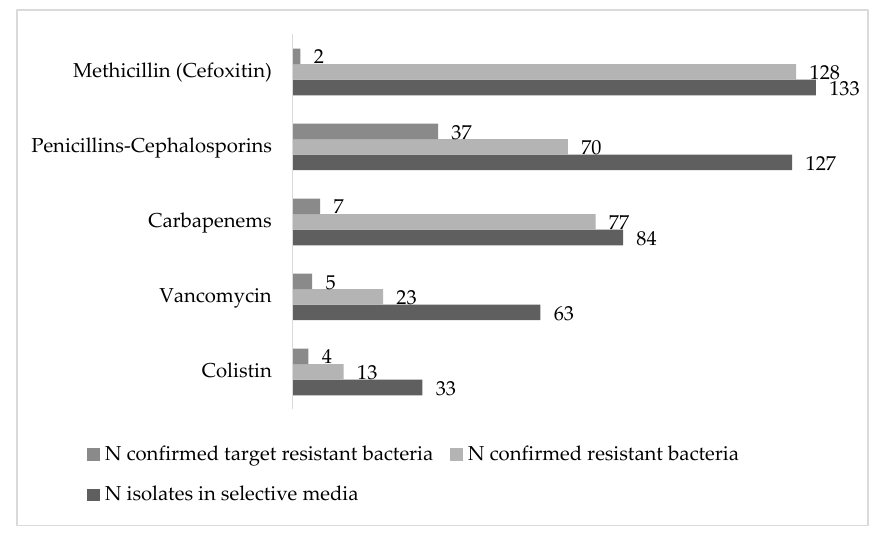
Figure 2. Total number of resistant strains isolated from water samples in the POCTEFA area.